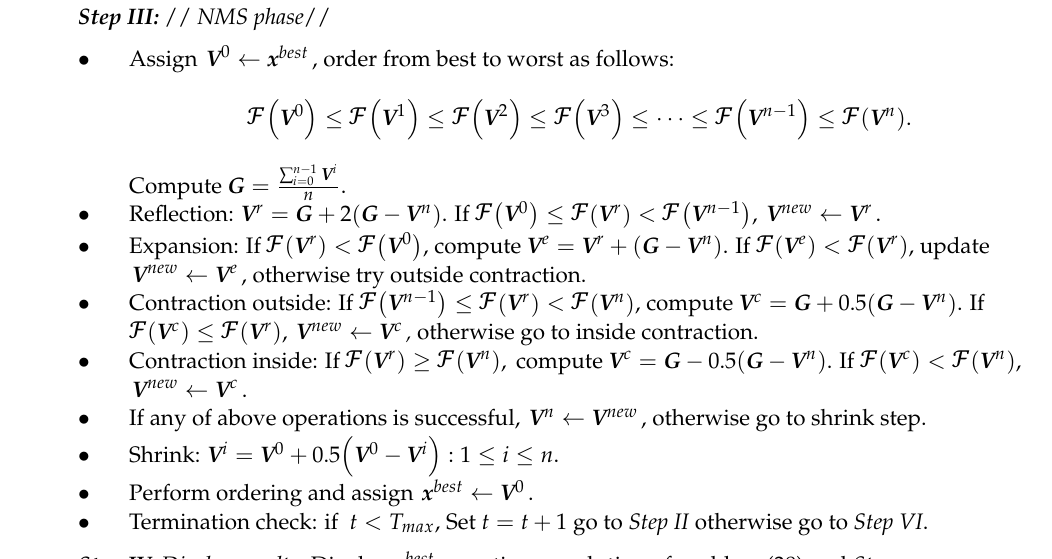
Figure 2. ( a ) DE based exploration in ℝ (cid:2870) ( b ) Schematic diagram of NMS method.